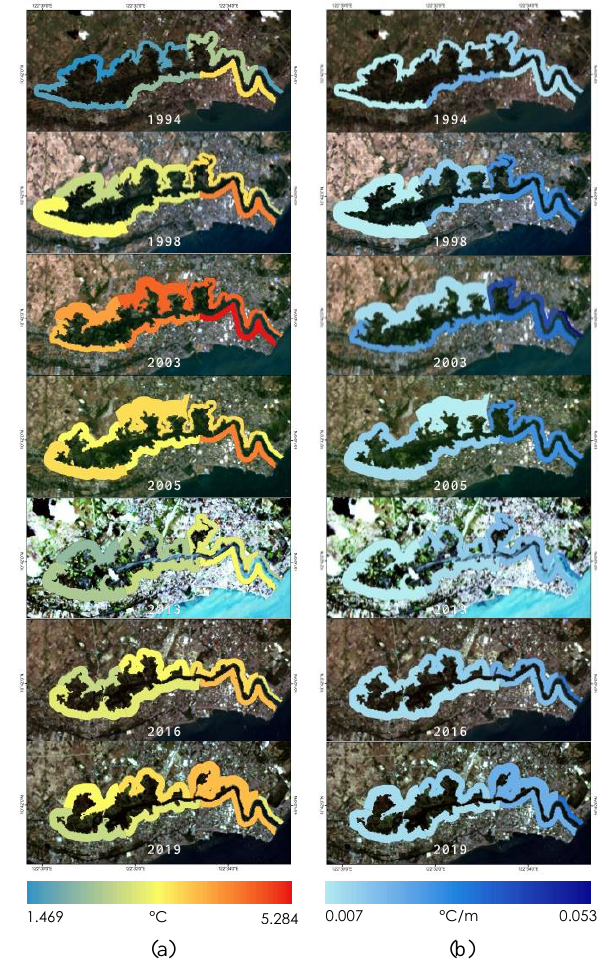
Figure 10. UCI scale and (a) temperature difference and (b) UCI intensity of each zone for each satellite image date